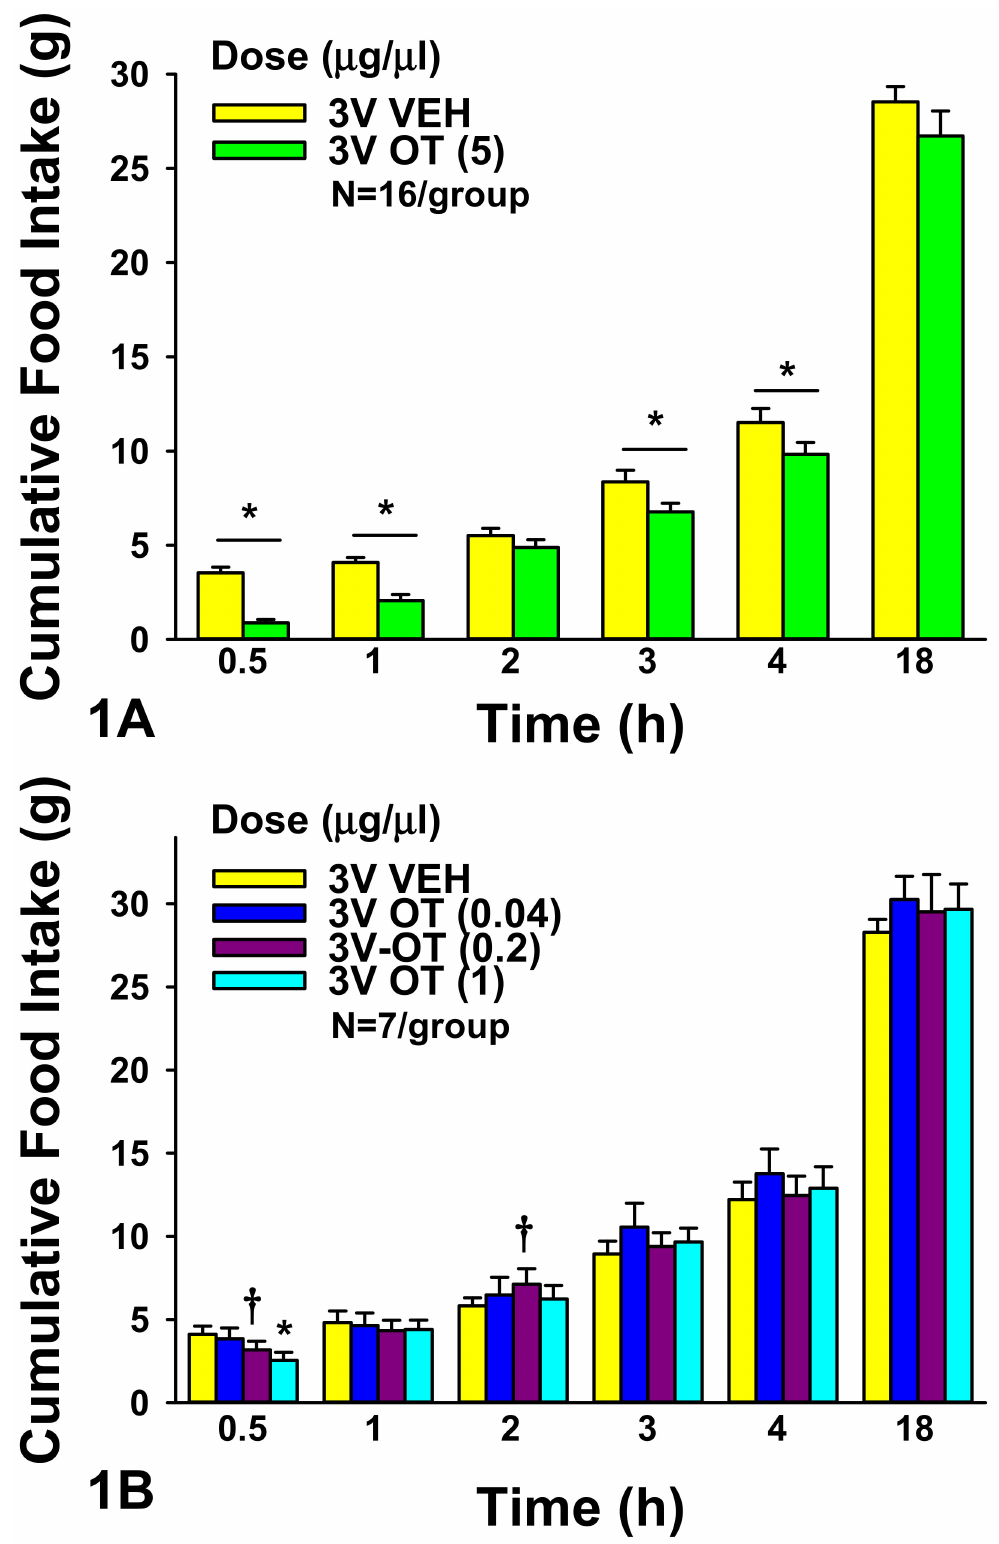
Figure 1. ( A , B ), Effect of acute 3V administration of OT on food intake in male chow-fed SD-SAS rats. ( A ), Food intake was measured in rats that received acute 3V injections of OT (5 µ g/ µ L) or vehicle (N = 16/group). ( B ), Food intake was measured in rats that received acute 3V injections of OT (0.04, 0.2, 1 µ g/ µ L; N = 7/group). Data are expressed as mean ± SEM. * P < 0.05 or † 0.05 < P < 0.1 OT vs.